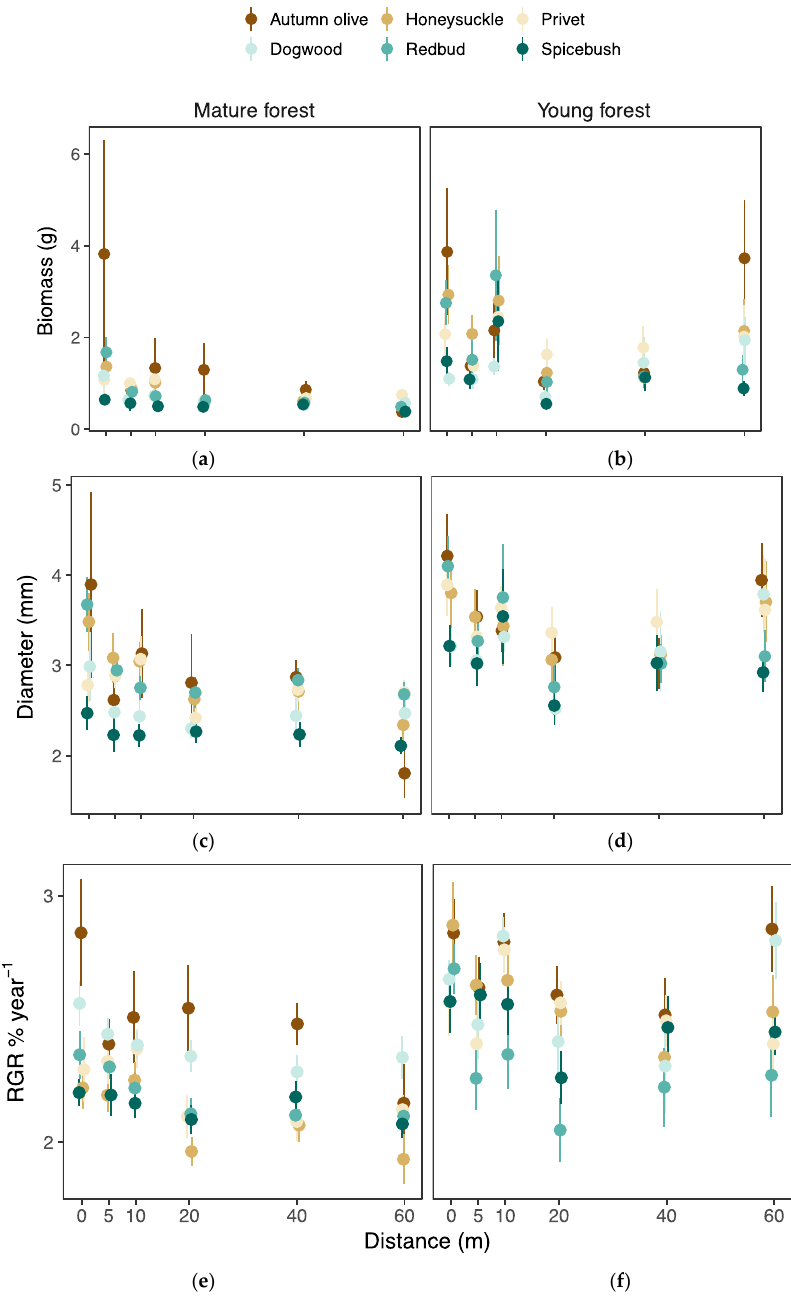
Figure 5. The mean and standard error of biomass, diameter, and relative growth rate (RGR) of each species in ( a , c , e ) mature and ( b , d , f ) young forests calculated from the observed data at each distance. The brown shading indicates the group of invasive species while the blue shading indicates the group of native species. Points are slightly jittered to reduce overlap at each